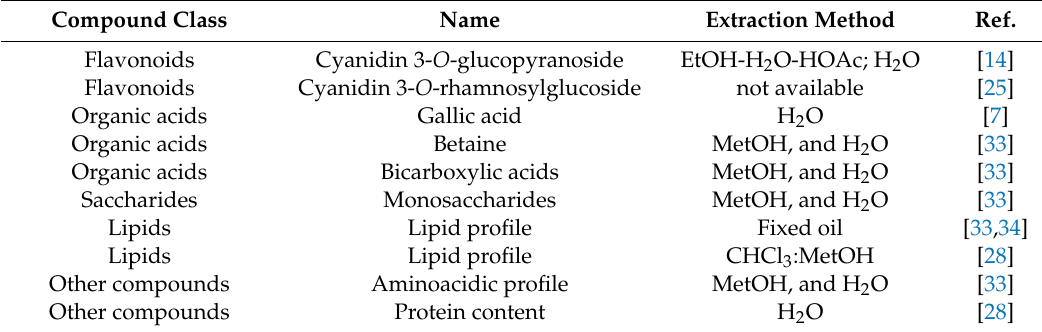
Table 2. Main phytochemicals reported in C. coccineum